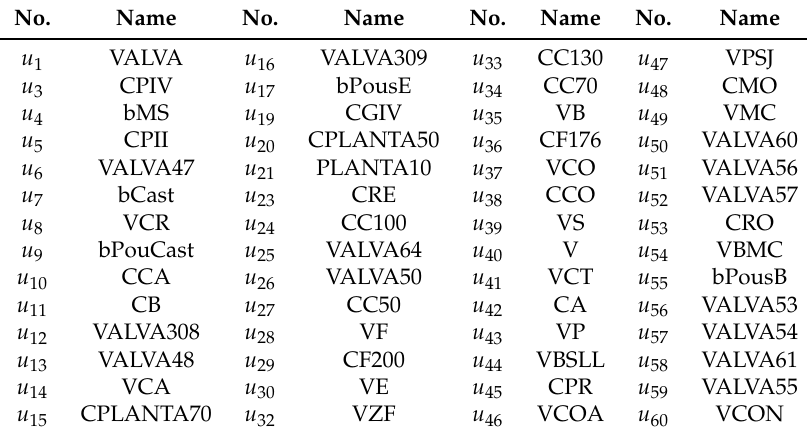
Table 1. Structural actuators (towards tanks).